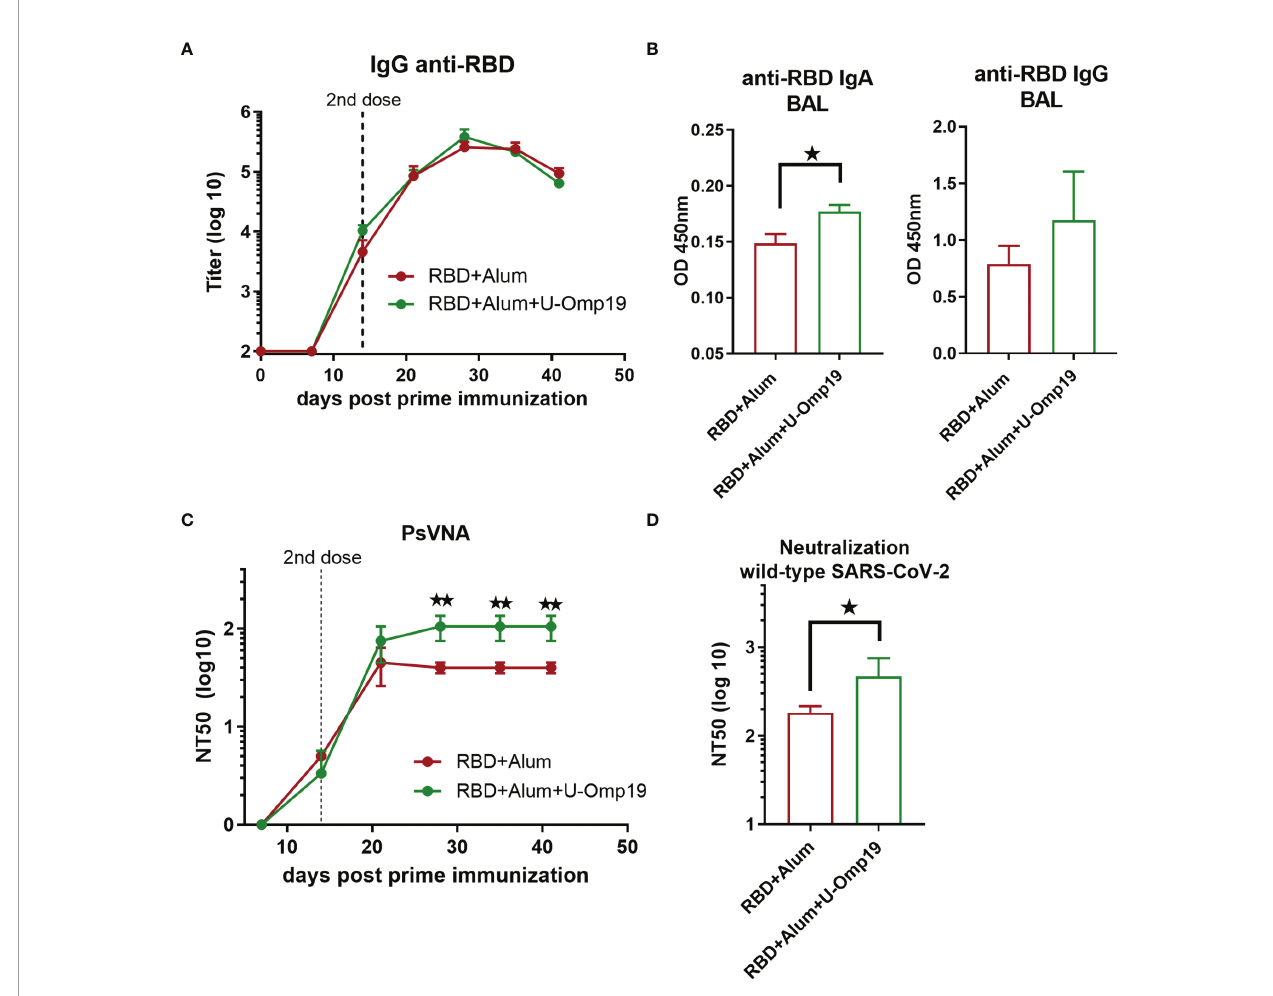
FIGURE 7 | U-Omp19 as adjuvant increases neutralizing antibodies in C57BL/6. Mice (n = 3 – 5/group) were vaccinated at days 0 and 14 via i.m route. with RBD +Alum or RBD+Alum+U-Omp19. (A) Kinetics of RBD-speci fi c IgG endpoint titer in sera of immunized animals by ELISA. Points are means ± SEM. (B) Detection of RBD-speci fi c IgA and IgG at the bronchoalveolar lavage of immunized mice at day 42 post prime immunization. Data are optical density (OD) at 450 nm. *p < 0.05. Mann – Whitney test. (C) Kinetics of neutralizing-antibody titers determined by pseudo-typed SARS-CoV-2 assay. Neutralization titer was de fi ned as the reciprocal serum dilution that causes a 50% reduction of transduction ef fi ciency (NT50). **p < 0.01. t-test. (D) Neutralization titers against ancestral SARS-CoV-2 virus at day 42. Neutralization titer was de fi ned as the serum dilution that reduces 50% the cytopathic effect (NT50). Data are shown as means ± SEM. *p < 0.05.